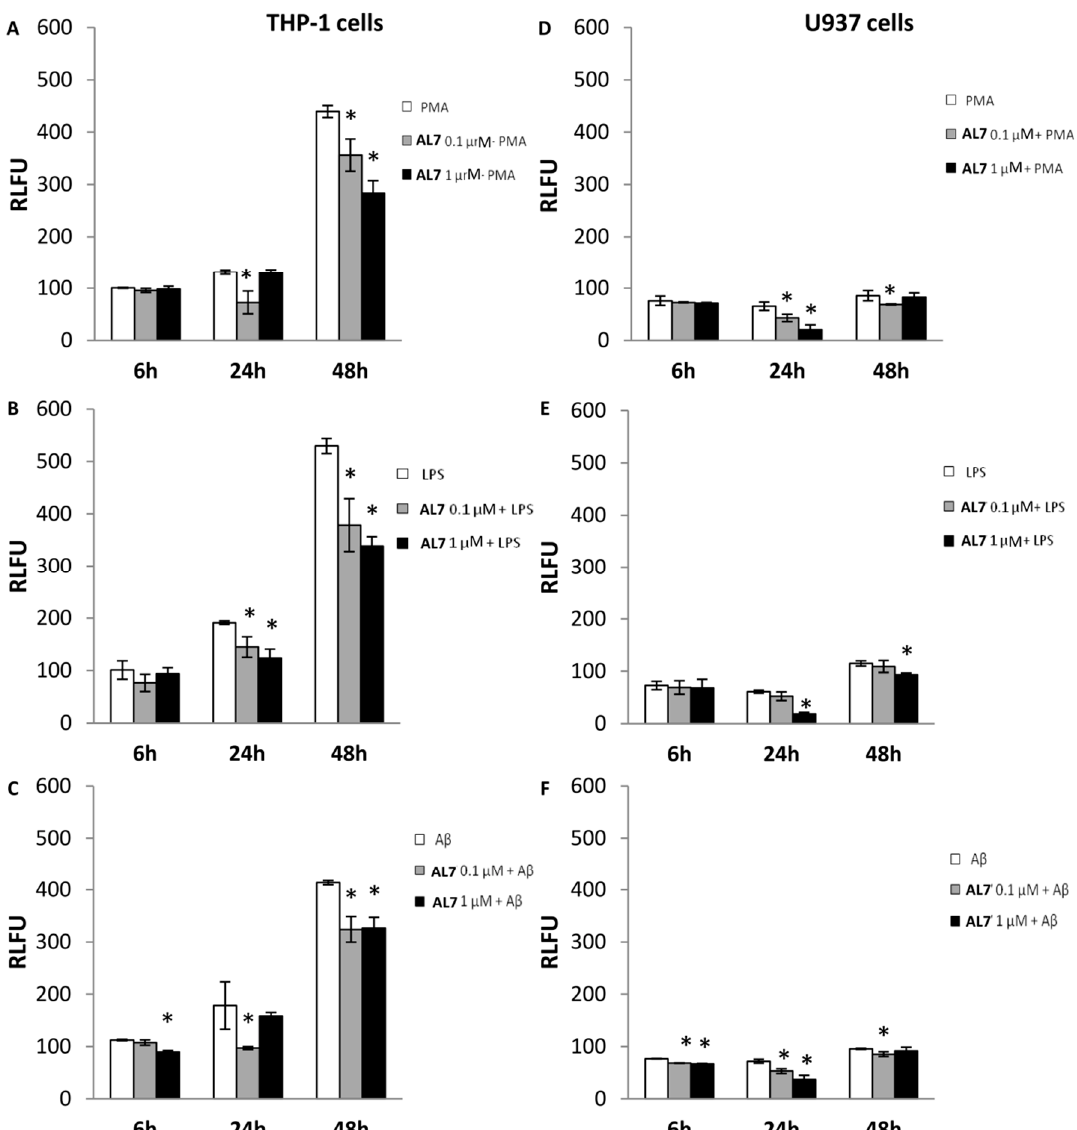
Figure 2. ROS scavenging properties of AL7 measured by DCFH-DA. Both cell lines were pre-incubated with AL7 at 0.1 and 1 μ M for 6, 24 and 48 h. ( A , D ) THP-1 and U937 cells were stimulated with phorbol 12-miristate 13-acetate (PMA) (100 nM); ( B , E ) THP-1 and U937 cells were stimulated with LPS (1 μ g/ μ L); ( C , F ) THP-1 and U937 cells were stimulated with A β (25-35) (10 μ M). The means ± SEM derived from three different experiments (each with n = 16; * p < 0.05, not significative p > 0.05). The mechanisms of toxicity of A β fragments with different lengths were extensively studied